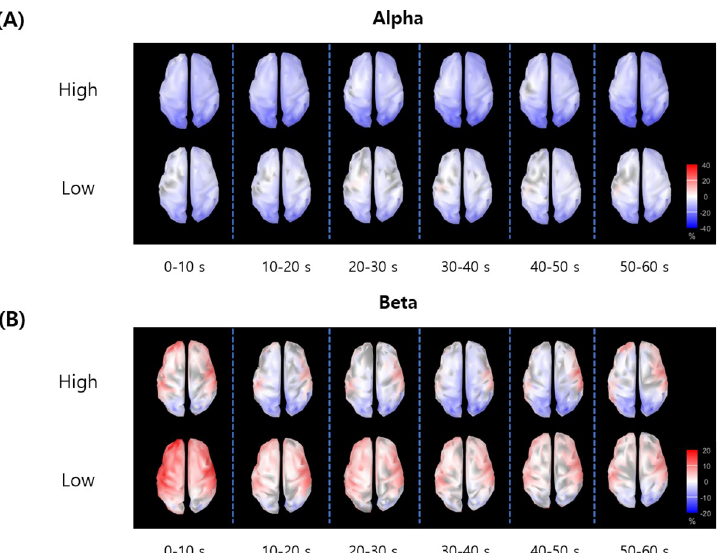
Fig 3. The distribution of spectral power changes over cortical surface at successive 10 s intervals. (A) Alpha-band and (B) beta-band.